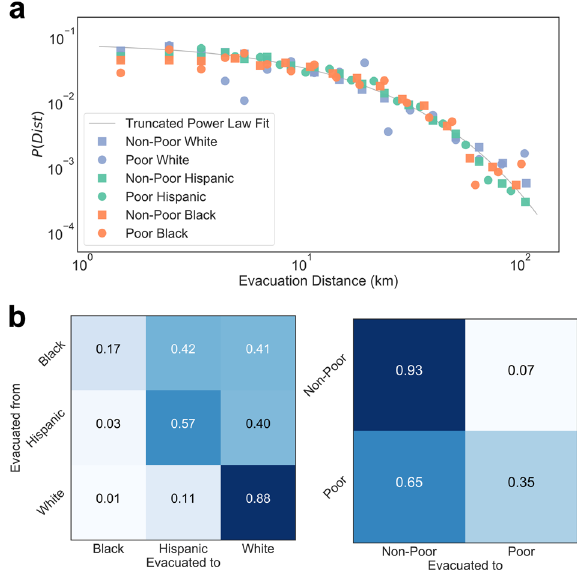
Fig. 3 Race and wealth impacts on evacuation/return times. a The kernel density of both departure and return of relocation activities. b Distribution of individual evacuation durations group by income and race difference in communities. Though most departure dates are tightly clustered within the fi rst week of Harvey ’ s landfall ( a , red), we fi nd a right-skewed distribution of return dates ( a , blue), with some Houston residents taking far longer to return than others. The tail of this distribution is formed mostly from residents of wealthier neighbourhoods of all racial compositions ( b ), suggesting only those residents could afford long